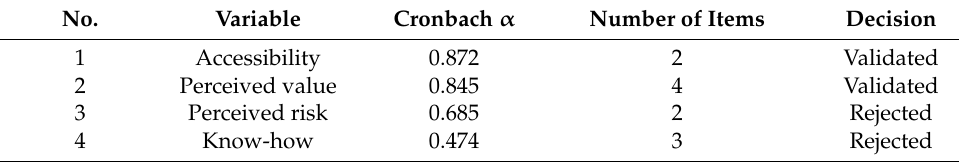
Table 3. Reliability analysis using Cronbach α